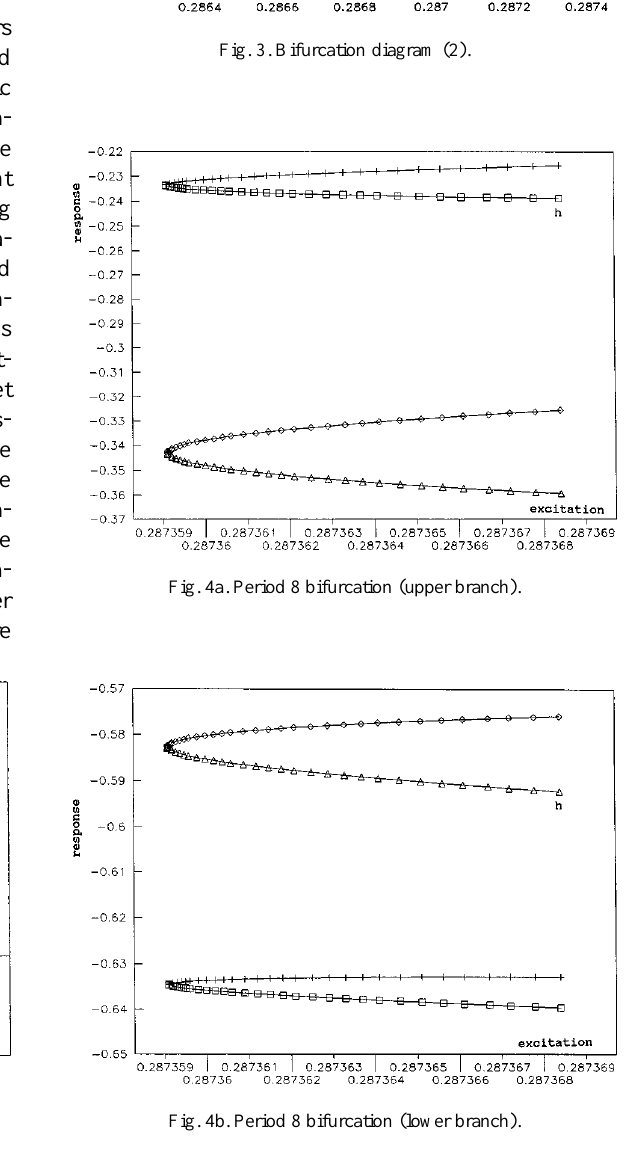
Fig. 3. Bifurcation diagram (2).